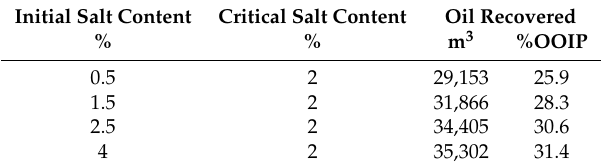
Table 6. Oil recovery efficiency as a function of the initial salt concentration in the